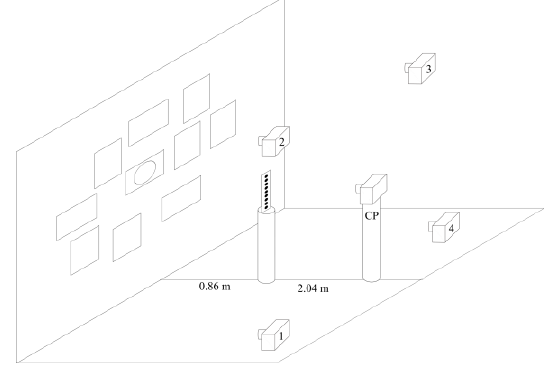
Figure 2. The camera calibration setup. On the right the wall with target sheets, in the middle the dotted target column, on the left the camera central position (CP) and the four positions around